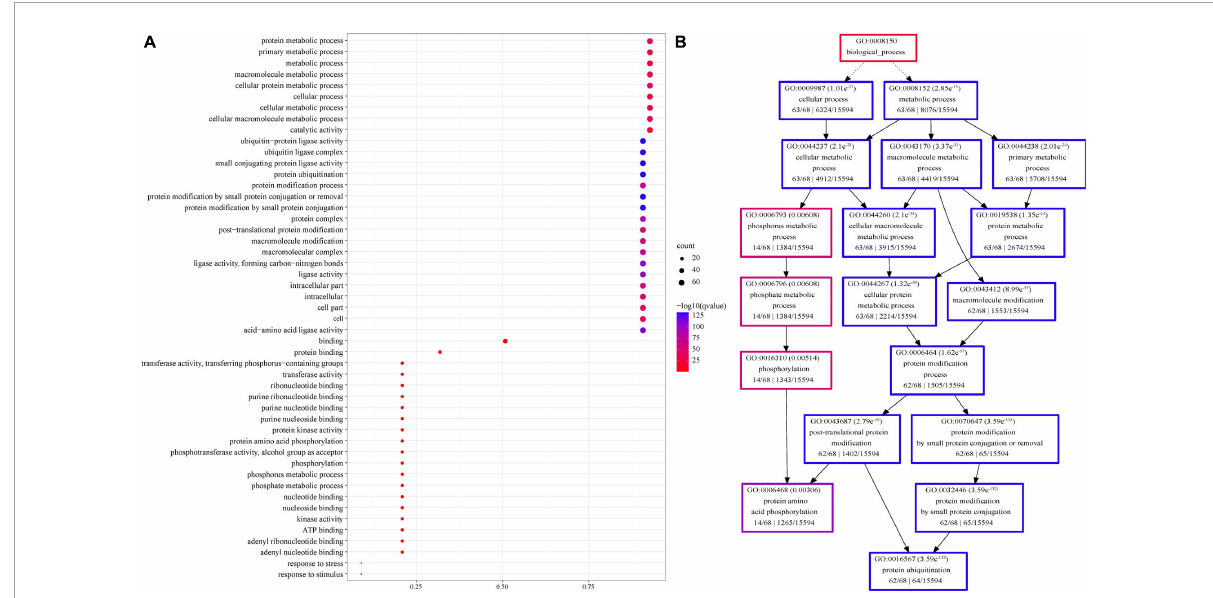
FIGURE6 Gene Ontology enrichment of sorghum U-box members. (A) GO enrichment presented as dot bubbles. (B) Corresponding pathway diagram of enriched GO terms. GO enrichment was conducted by Agrigo, and corrected p -values were calculated by R version 3.6.2.